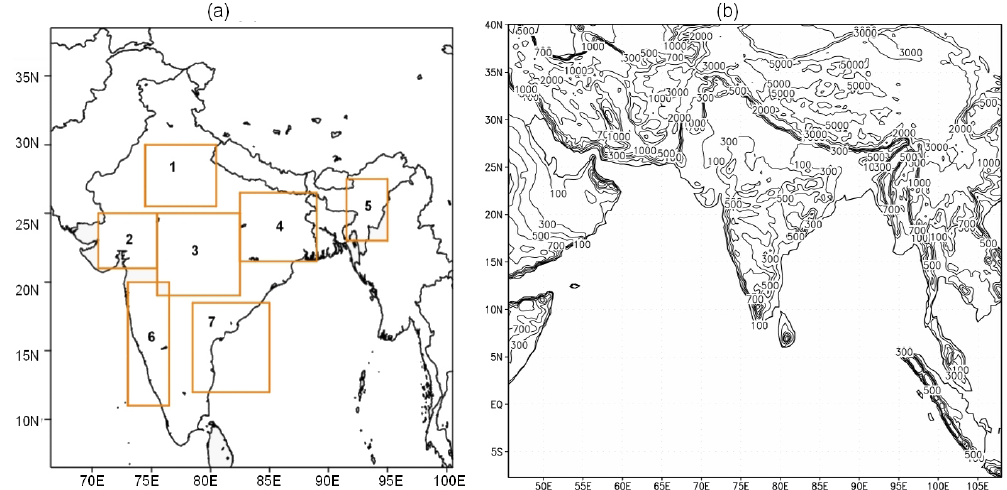
Figure 1. (a) Map showing the climatic zones used for rainfall analysis and (b) simulation domain used in the ARW model along with terrain elevation (in